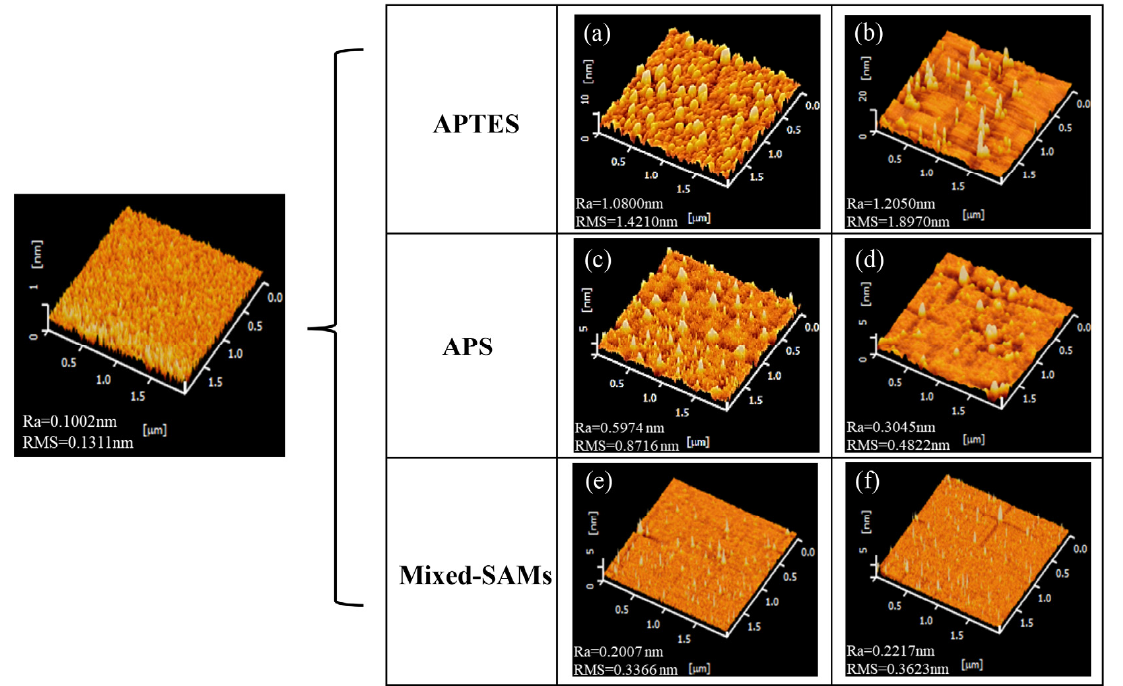
Figure 1. AFM images of silica surfaces. This figure shows two representative AFM images for each modified surface sampled in different areas. ( a , b ) APTES-modified silica surface; ( c , d ) APS-modified silica surface; and ( e , f ) mixed-SAMs-modified silica surface.